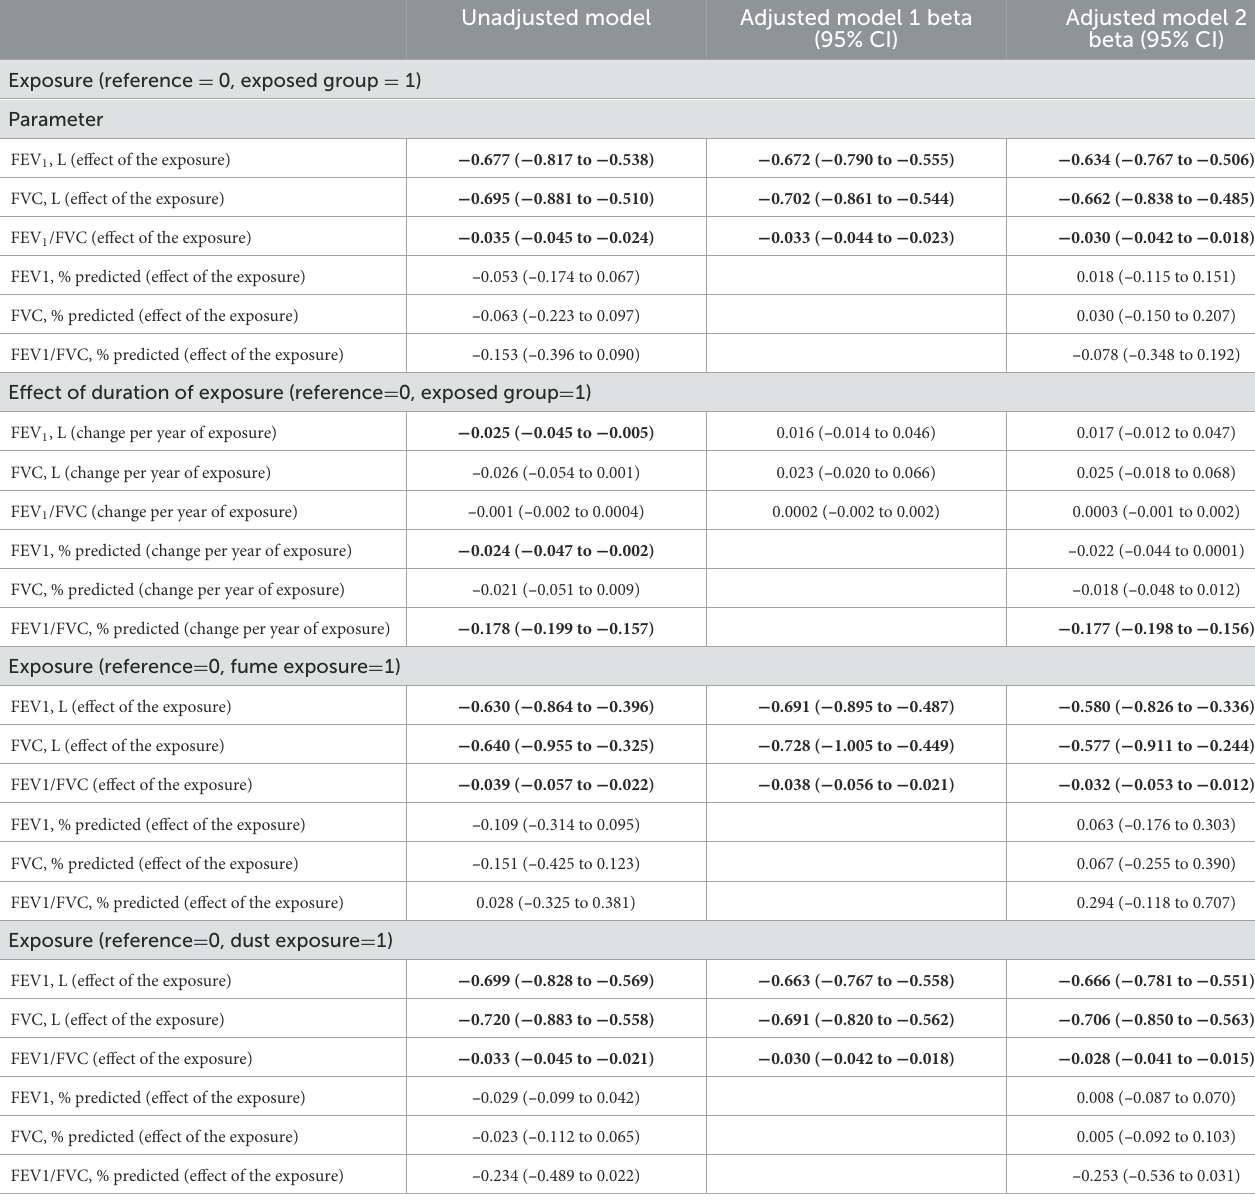
TABLE 4 Effects on lung function parameters in relation to any exposure, duration of exposure and exposure to fumes and dusts